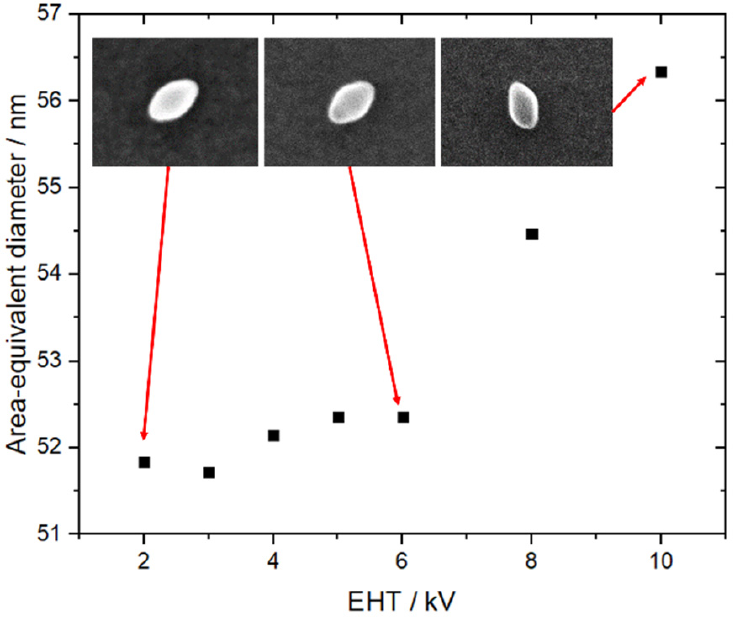
Figure 4. Area-equivalent diameter of a set of TiO 2 nanoparticles as a function of the accelerating voltage ranging from 2 to 10 kV.